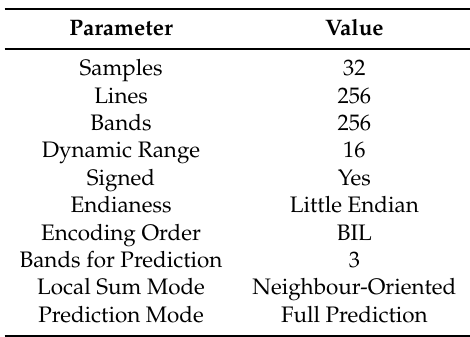
Table 2. Main configuration